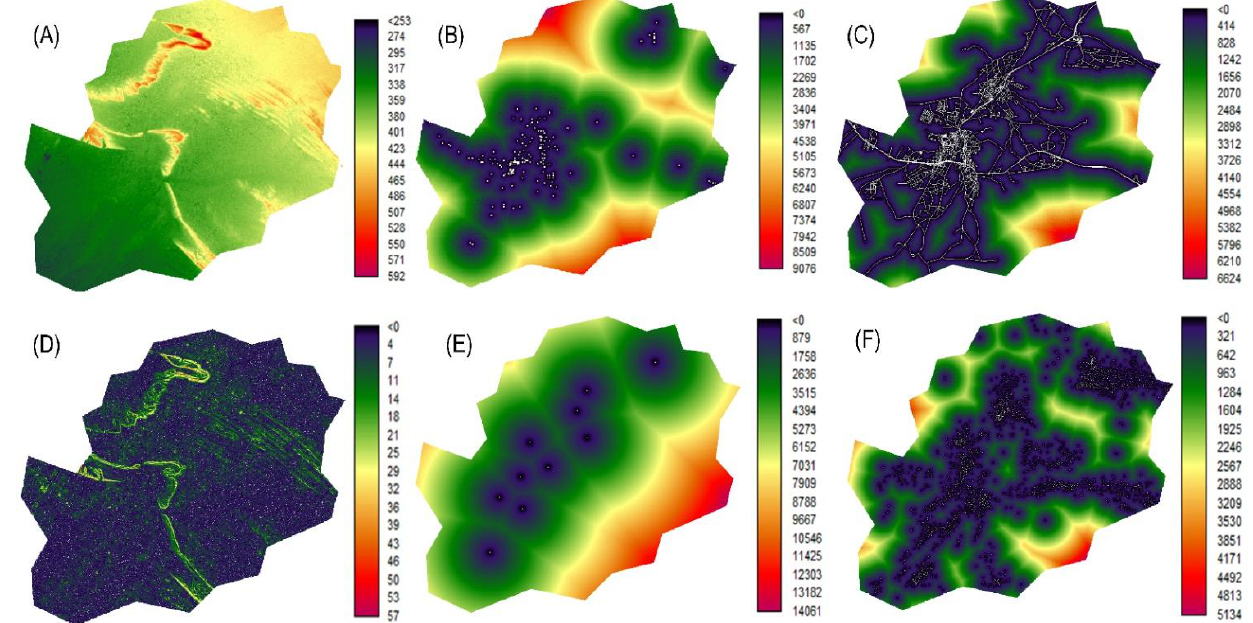
Figure 4. Standardised driving forces (variables) used in the simulation process: elevation ( A ); POIs ( B ); distance from roads ( C ); slopes ( D ); distance from urban centres ( E ); distance from water wells ( F ).